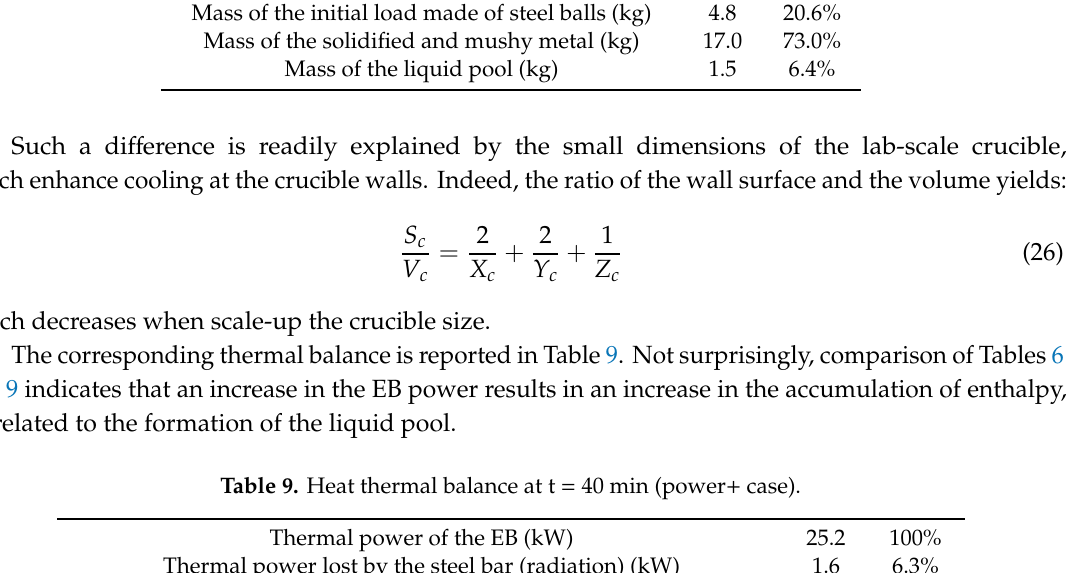
Figure 16. Computed cross-section of the crucible ( X = 6.25 cm) at the end of melting (t = 40 min), showing the initial load, solidified steel and liquid pool predicted by the numerical model. “power + ” case. Table 8. Masses of the three parts of the charge at t = 40 min (“power + ” case).